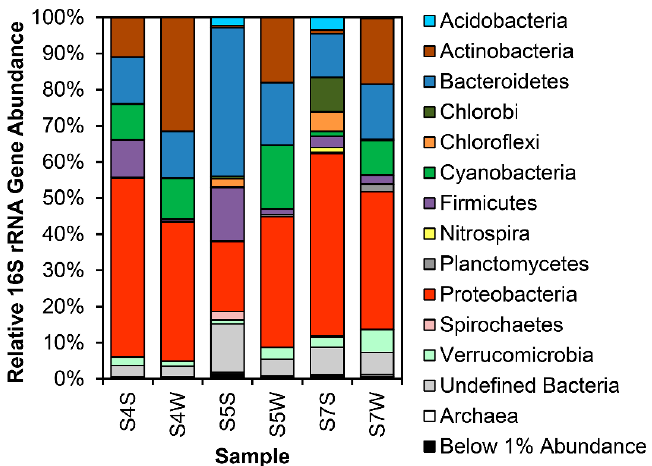
Figure 2. Phylum-level 16S rRNA gene relative abundances at sites 4, 5 and 7 around the Calumet Wetlands. All samples were collected in August 2013. S*W and S*S denote soil and water samples from the corresponding site. Diversity 2019 , 11 , x FOR PEER REVIEW